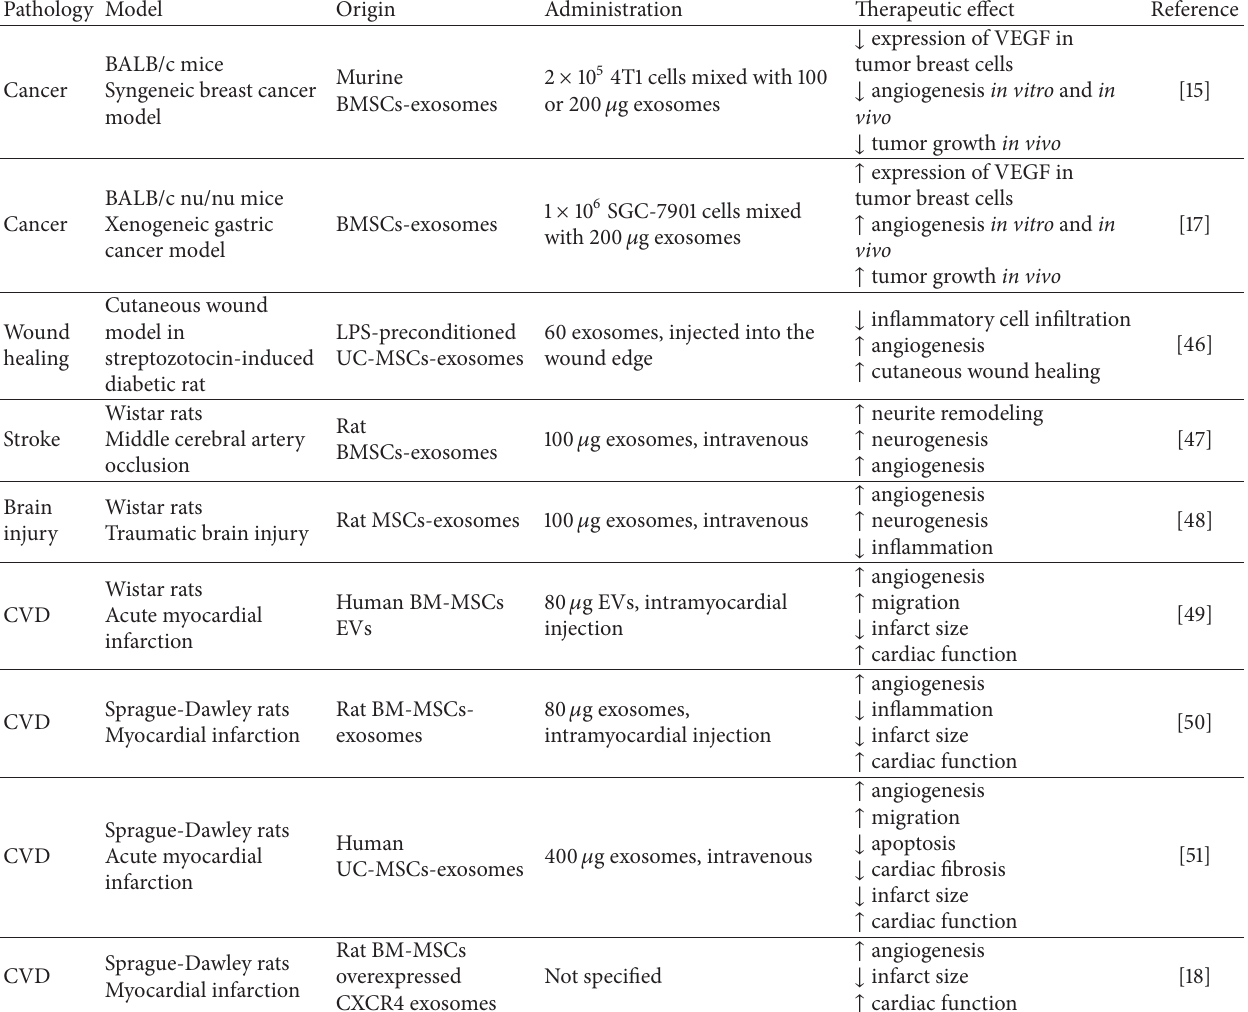
Table 2: Summary of MSCs-derived exosomes in different